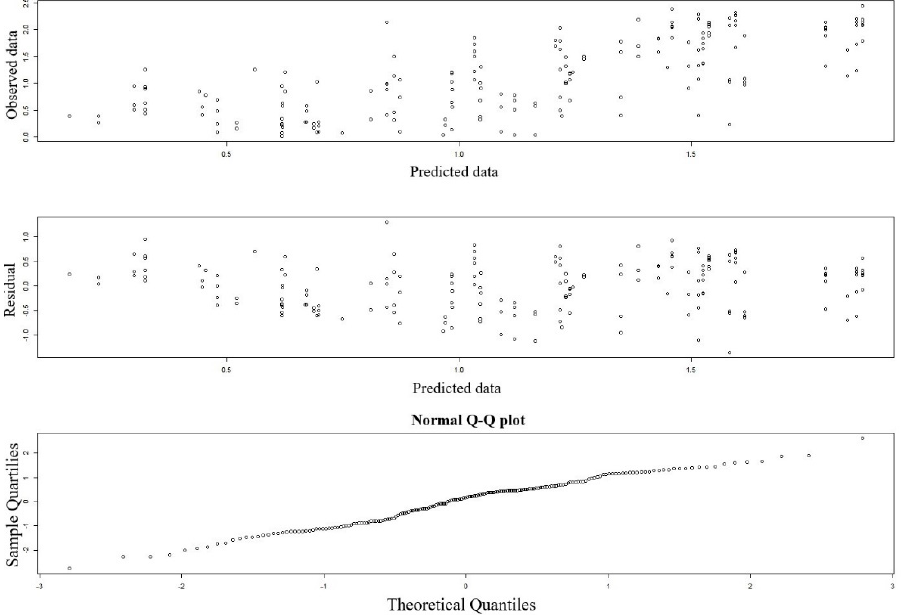
Figure A1. Plots of observed vs. predicted values, residuals vs. predicted values, and normal Q–Q.